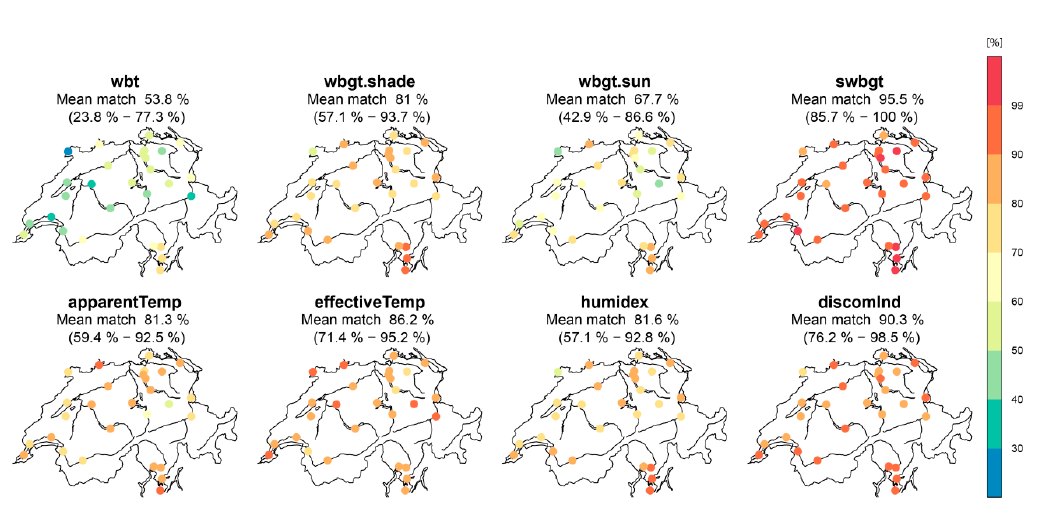
Figure 7. Percentage of matches of single warning days based on site-specific thresholds compared to official warning days based on the hi exceeding 90 °F, analyzed for the considered indices wbt, wbgt.shade, wbgt.sun, swbgt, apparentTemp, effectiveTemp, humidex, discomInd . Blue colors apply to lower matches, red colors to higher matches.